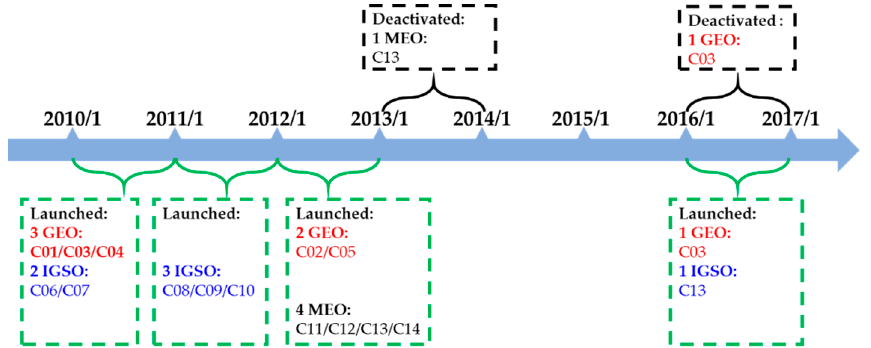
Figure 1. The second-generation of the Beidou Navigation Satellite System (BDS-2) satellite launching and deactivation status.